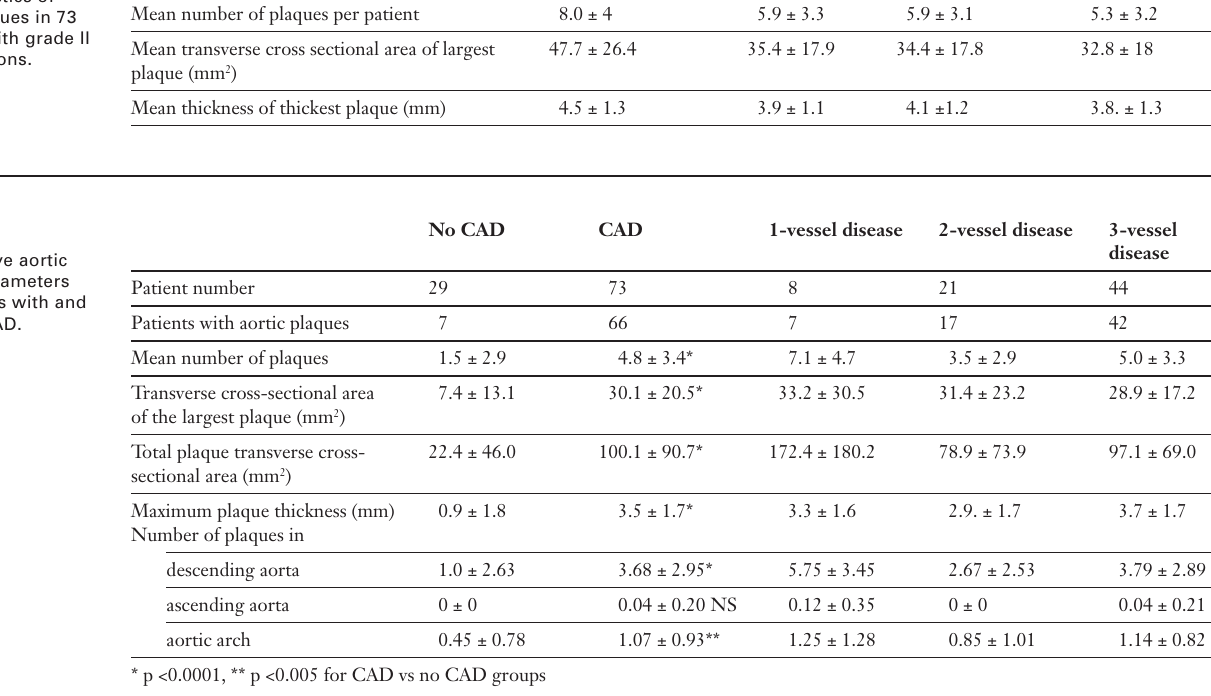
Distribution and characteristics of aortic plaques in 73 patients with grade II and III lesions.